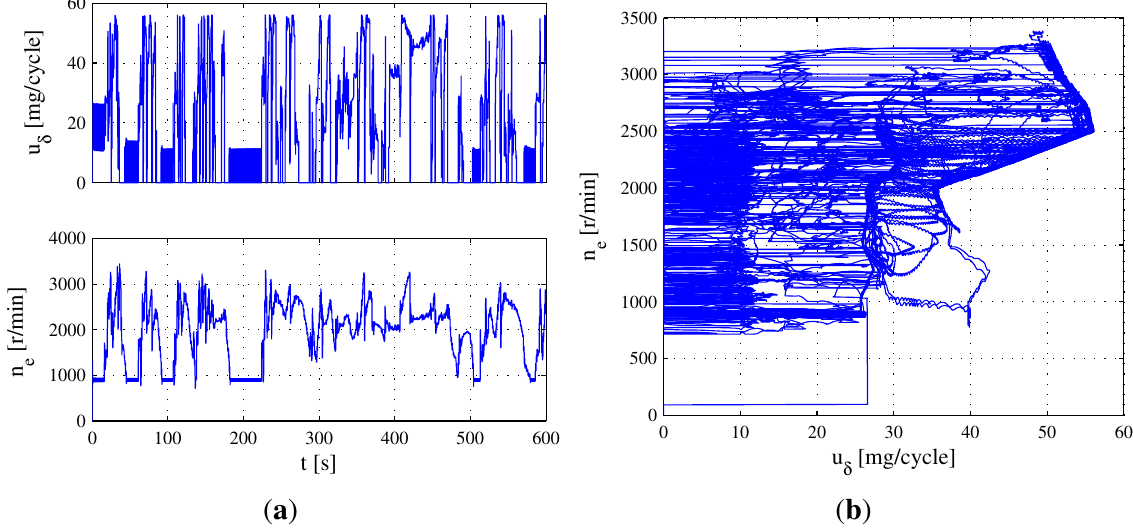
, n ) during ETC part one. ( a ) Evolution of δ e , n ) δ e